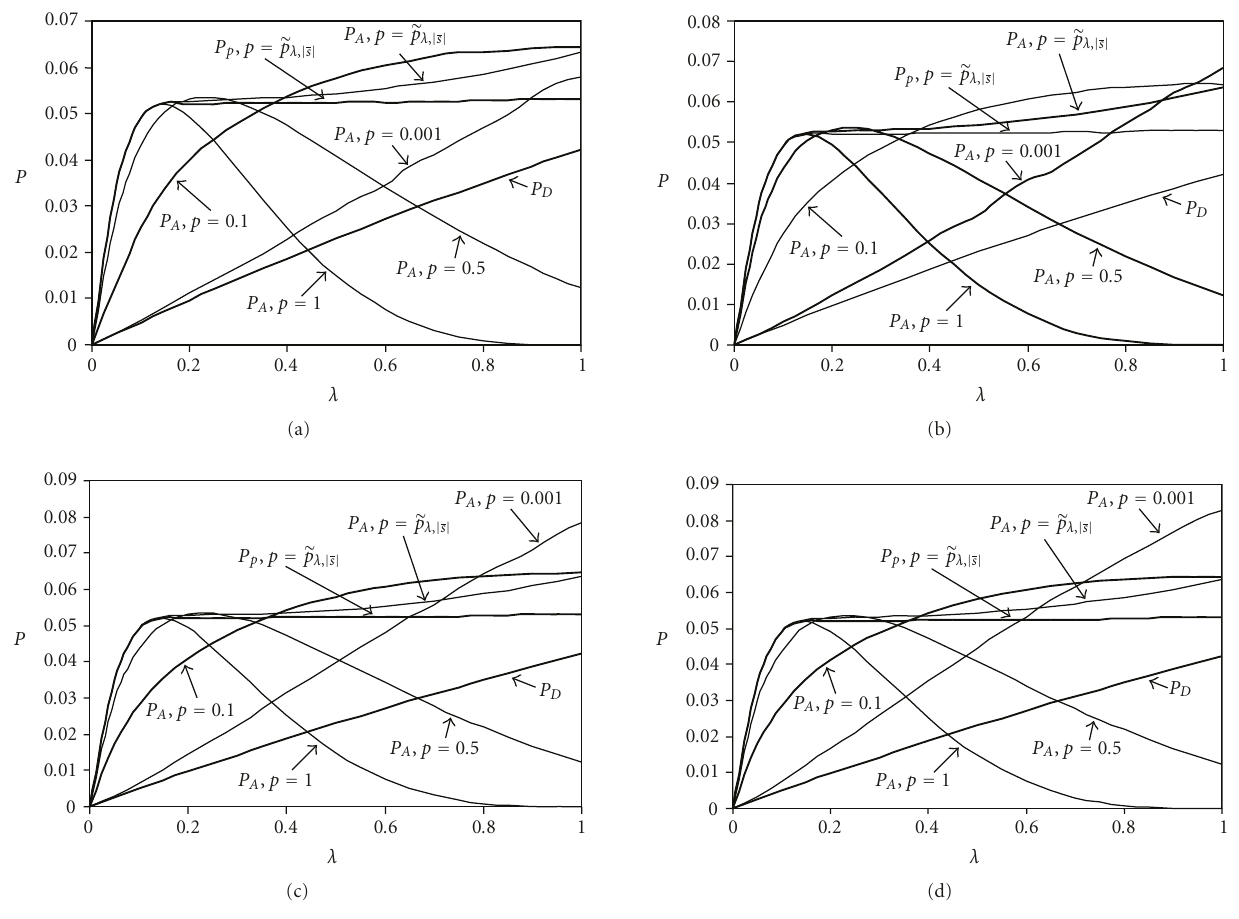
Figure 3: System throughput ( P ) simulation results as a function of λ averaged over di ff erent numbers of